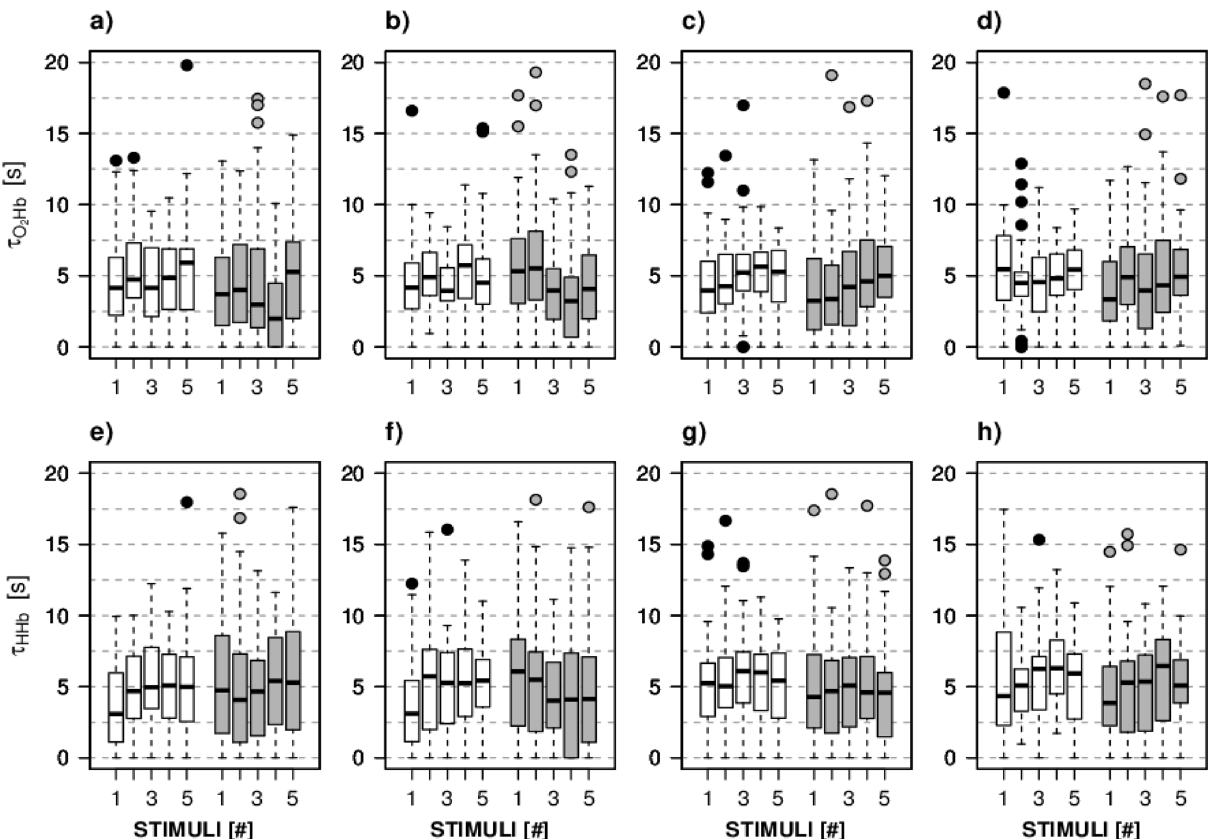
Figure 3. Distribution of τ O2Hb ( a–d ) and τ HHb ( e–h ) over the 5 stimuli for healthy eyes (NORM, white) and glaucomatous eyes (GLAUCOMA, grey). ( a,e ) Left eye, left hemisphere; ( b,f ) left eye, right hemisphere; ( c,g ) right eye, left hemisphere; ( d,h ) right eye, right